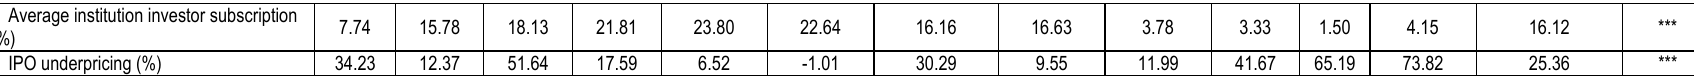
Table 4. (cont.). Summary statistics for Thai